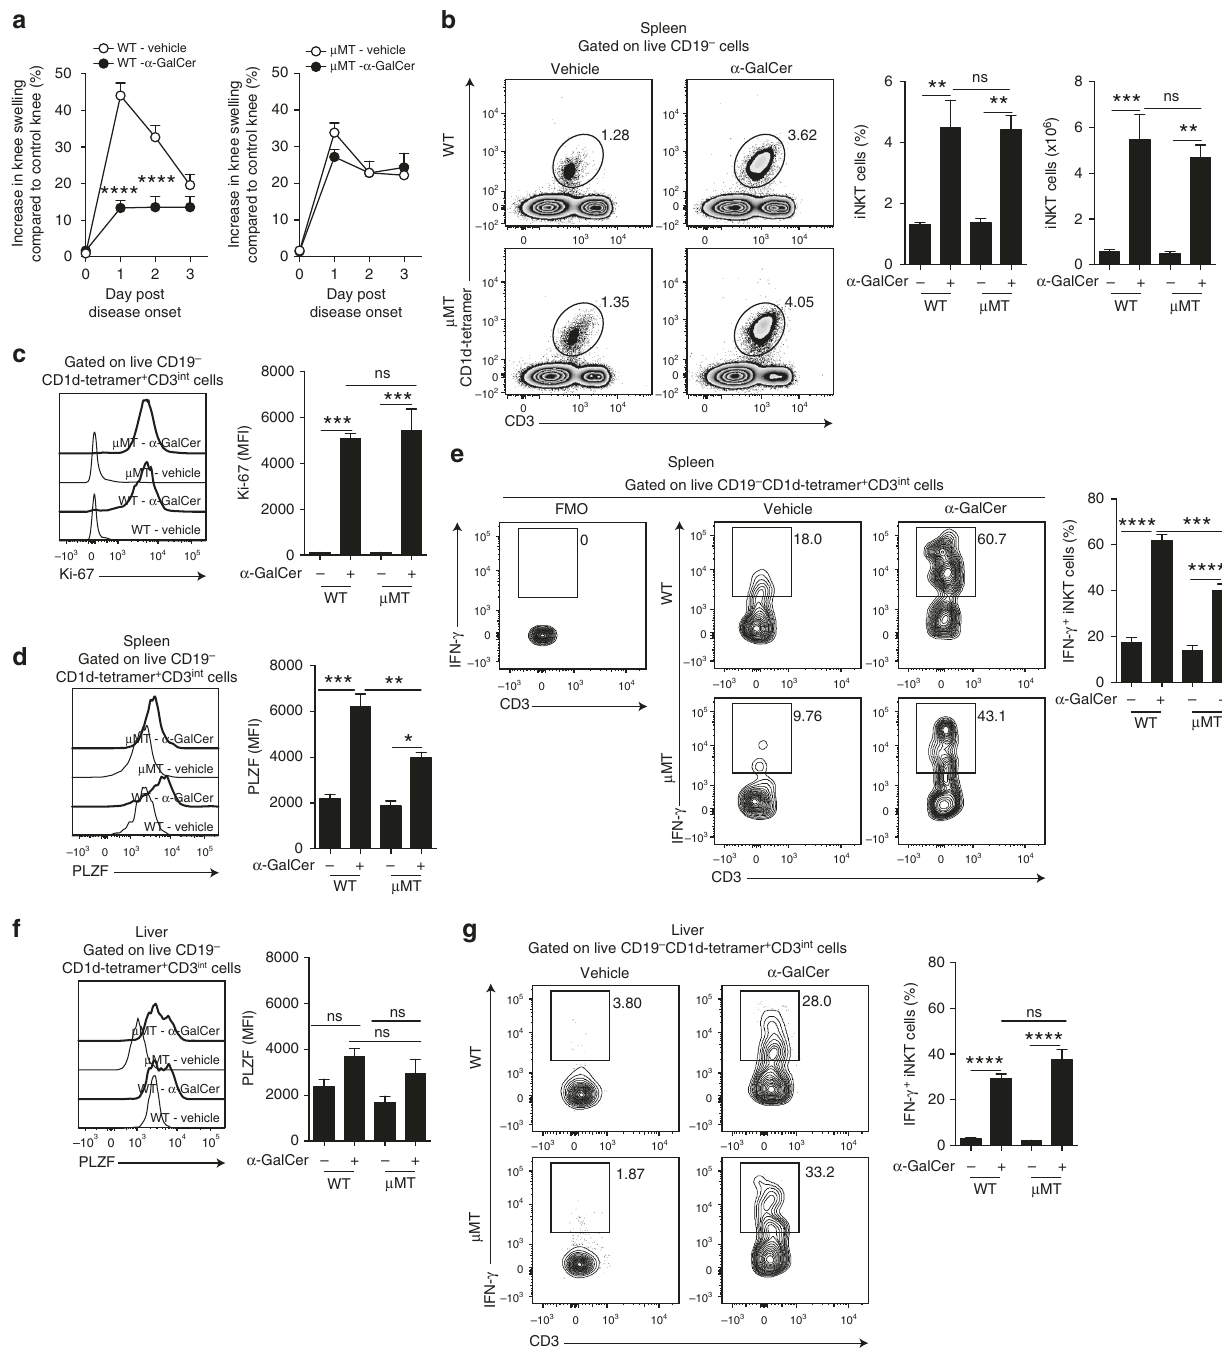
Fig. 1 α -GalCer-iNKT-cell-dependent amelioration of arthritis requires B cells. a Mean clinical score of wild-type (WT) mice (left) and μ MT mice (right) that received α -GalCer or vehicle alone following induction of arthritis. The Y axis shows the percentage of swelling in antigen-injected knee compared to control knee ( μ MT ± α -GalCer n = 14 per group, WT ± α -GalCer n = 20 per group, one of three experiments is shown). b Representative fl ow cytometry plots and bar charts showing the frequency and number of splenic iNKT cells in μ MT and WT mice that received α -GalCer or vehicle alone ( n = 5 per group, one of three experiments is shown). c Representative histograms and bar chart showing median fl uorescence intensity (MFI) of Ki-67 in splenic iNKT cells from α -GalCer- or vehicle-treated μ MT and WT mice ( n = 3 per group, one of three experiments is shown). d Representative histograms and bar chart showing MFI of PLZF in splenic iNKT cells from α -GalCer- or vehicle-treated μ MT and WT mice ( n = 3 per group, one of three experiments is shown). e Representative fl ow cytometry plots and bar chart showing the frequency of IFN- γ + splenic iNKT cells from α -GalCer- or vehicle-treated μ MT and WT mice ( n = 4 per group, one of three experiments is shown). f Representative histograms and bar chart showing MFI of PLZF in hepatic iNKT cells from α - GalCer- or vehicle-treated μ MT and WT mice ( n = 3 per group, one of two experiments is shown). g Representative fl ow cytometry plots and bar chart showing the frequency of IFN- γ + hepatic iNKT cells from α -GalCer- or vehicle-treated μ MT and WT mice ( n = 4 per group, one of three experiments is shown). b , c Analyzed on day 3 post disease onset, d – g analyzed at 16 h post disease onset. Data are mean ± s.e.m. ns not signi fi cant, * p < 0.05, ** p < 0.01, *** p < 0.001, and **** p < 0.0001 ( a two-way analysis of variance (ANOVA), b – g one-way